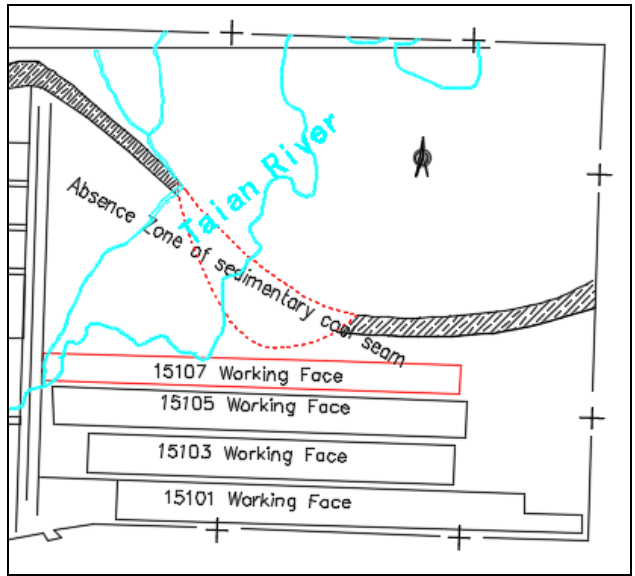
Figure 2. WF15107 and the oxidized zone.